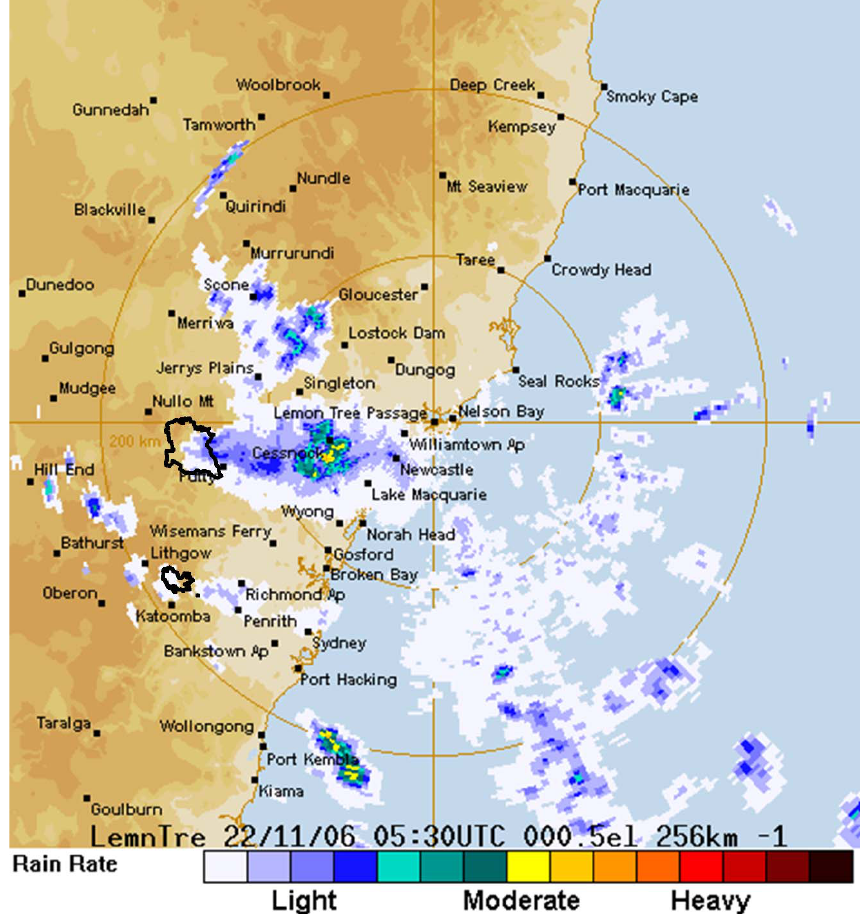
Figure 6. Newcastle (Lemon Tree Passage) radar rain-rate product for 22 November 05:30. The black outlines are the burnt areas. The diagonal band of instability that is about to pass over the radar site from the west (situated between Scone and Lake Macquarie and extending to the SE into the Tasman Sea) is strongly interacting with the plume from the Wollemi fire (between Putty and